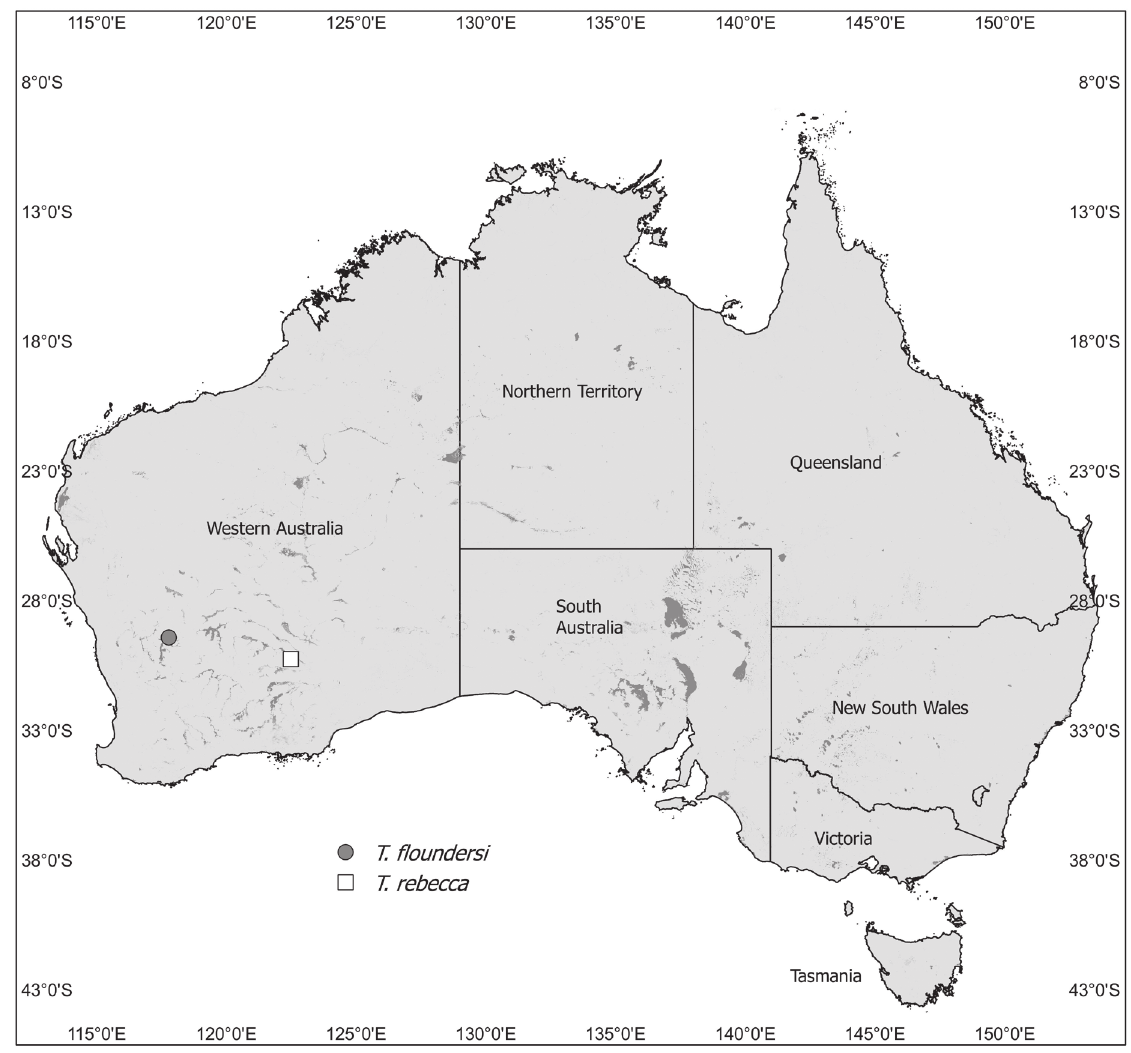
Fig. 21. Tetralycosa floundersi sp. nov. and T. rebecca sp. nov., distribution records in